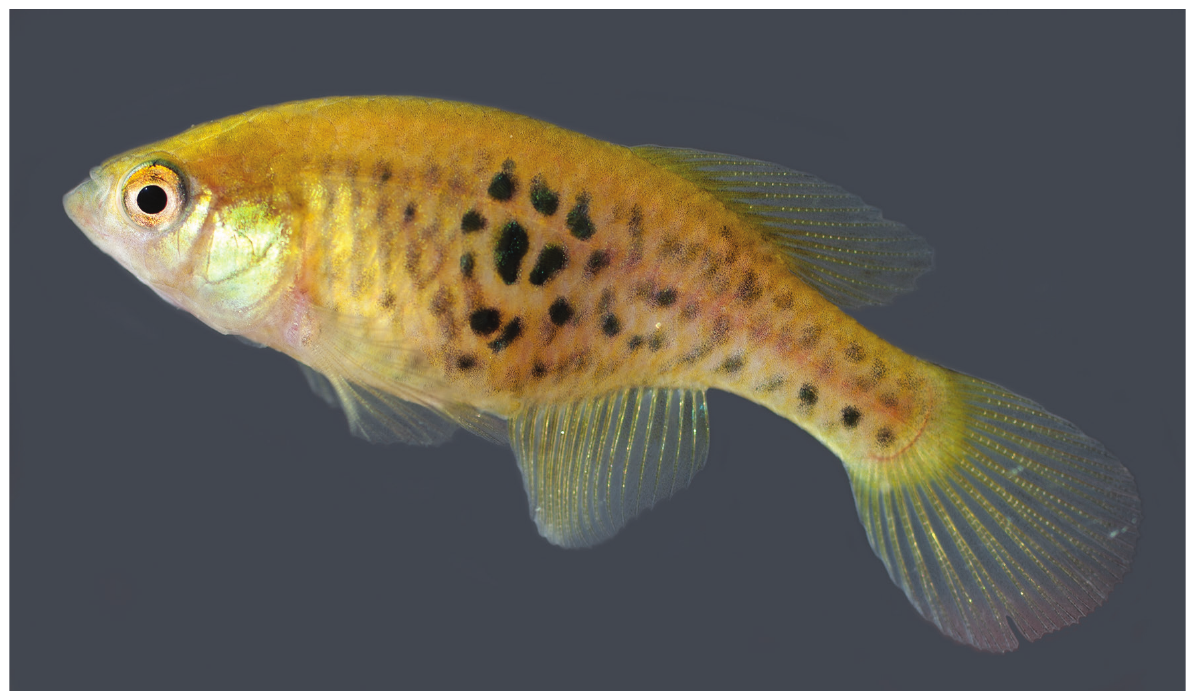
Figure 3. Hypsolebias splendissimus Costa sp. n., live paratype, UFRJ 6779, female, 28.5 mm SL. Photograph by W.J.E.M.